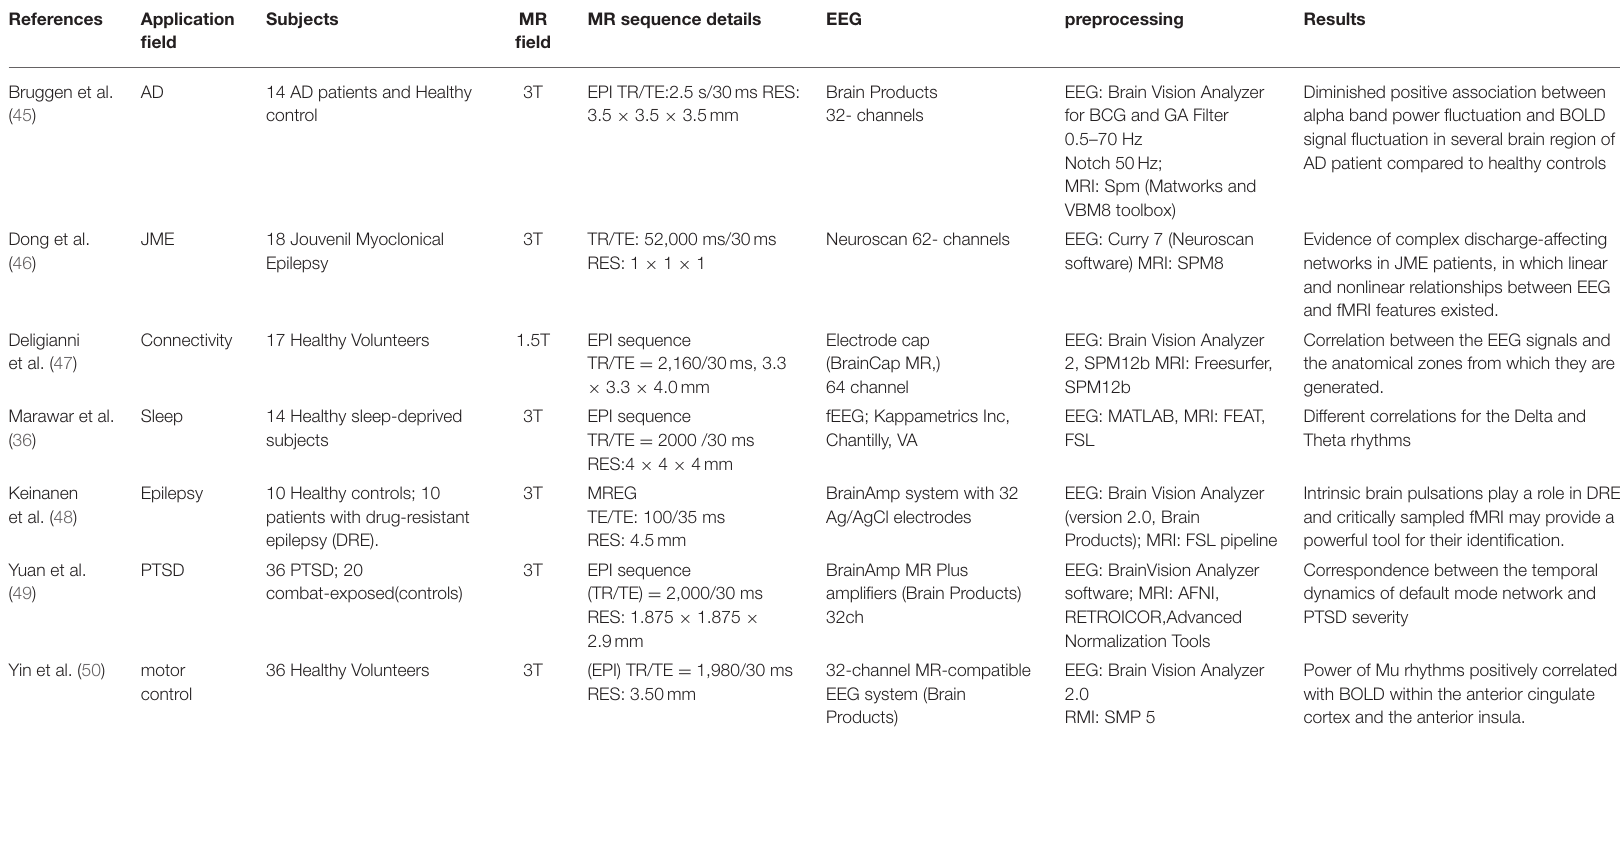
TABLE 1 | A summary of the resting state EEG-fMRI studies since